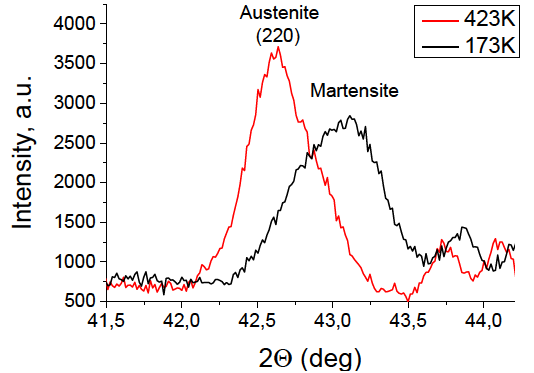
Figure 5: XRD patterns of Ni 55 Mn 32 In 13 sample at different tempera- tures (423 and